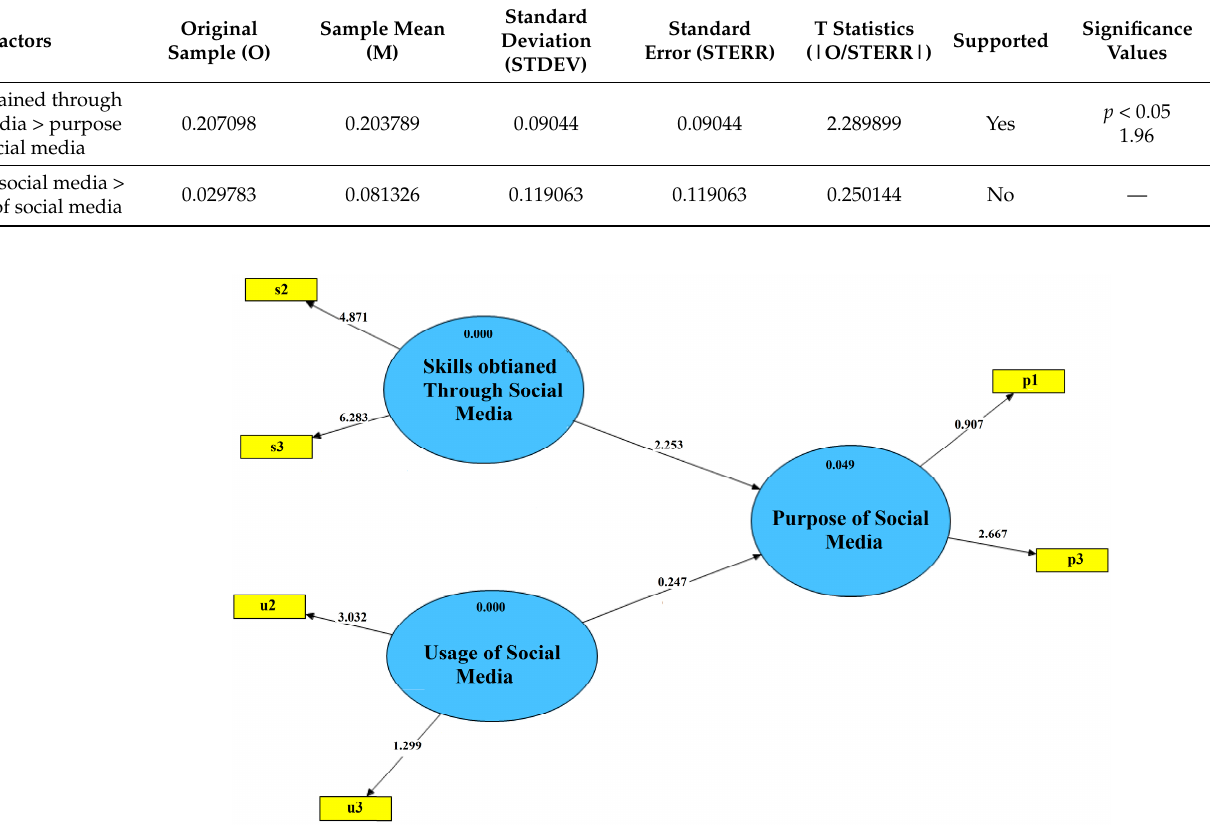
Figure 6. Values of selected variables after implement the PLS bootstrap method. Table 6. Bootstrap values and T-values of path coefficients.